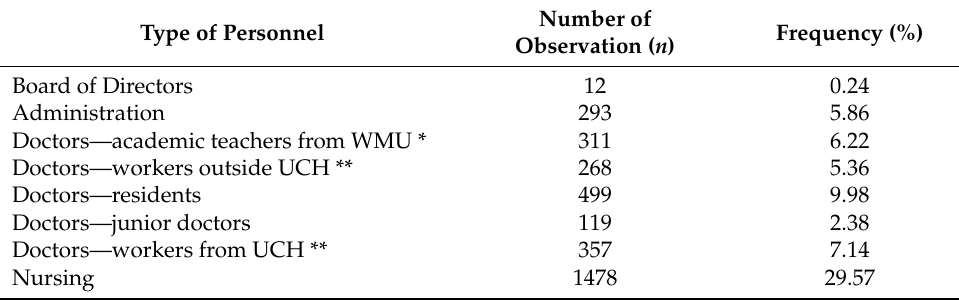
Table 2. The structure of the healthcare workers in the study